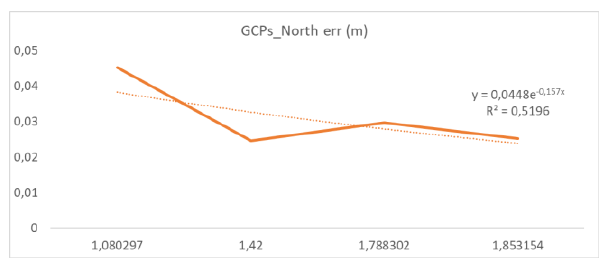
Figure 11. Predictive function extracted through an exponential interpolation between depend (synthetic index) and independent variables (northern error component). R 2 : coefficient of determination. Figure 15. Predictive function extracted through a logarithmic interpolation between depend (synthetic index) and independent variables (eastern error component). R 2 : coefficient of